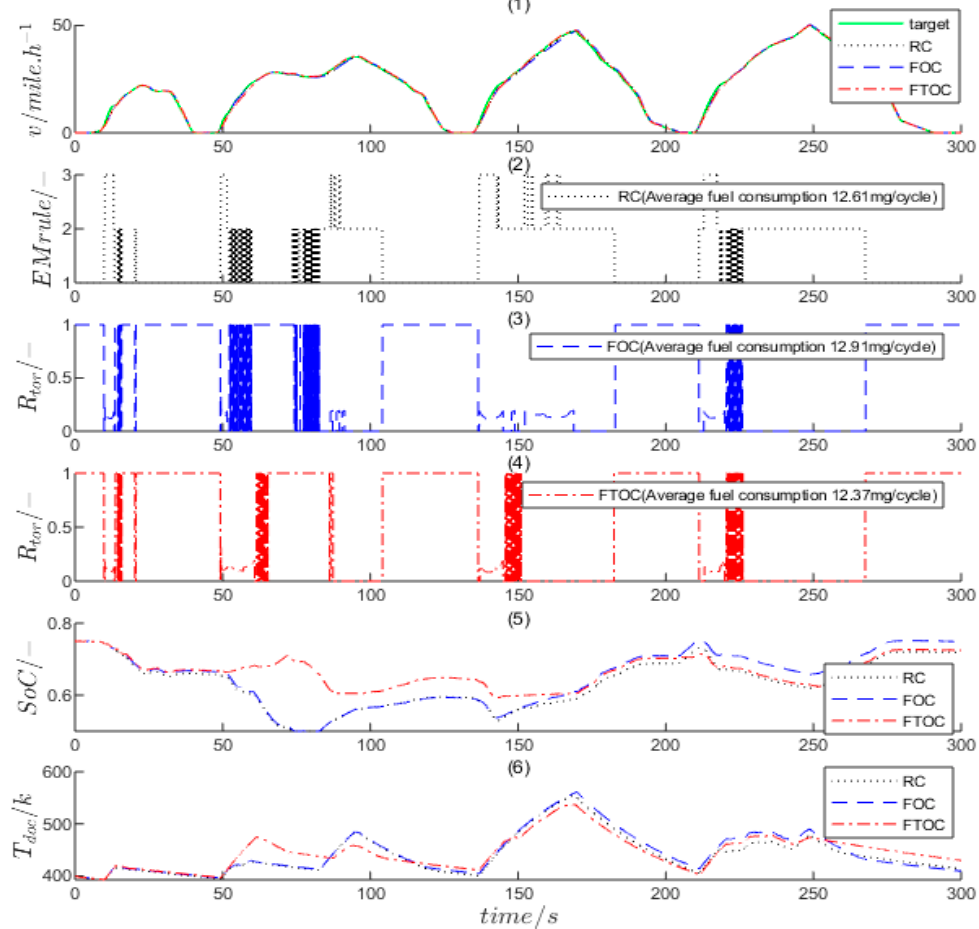
Figure 11. Comparison results of the RC vs. the FOC vs. the FTOC: ( 1 ) the speed target of the cycle and the tracking states of the controllers, ( 2 ) energy mode rule of the RC, ( 3 ) R tor of the FOC, ( 4 ) R tor of the FTOC, ( 5 ) SoC , ( 6 ) T doc